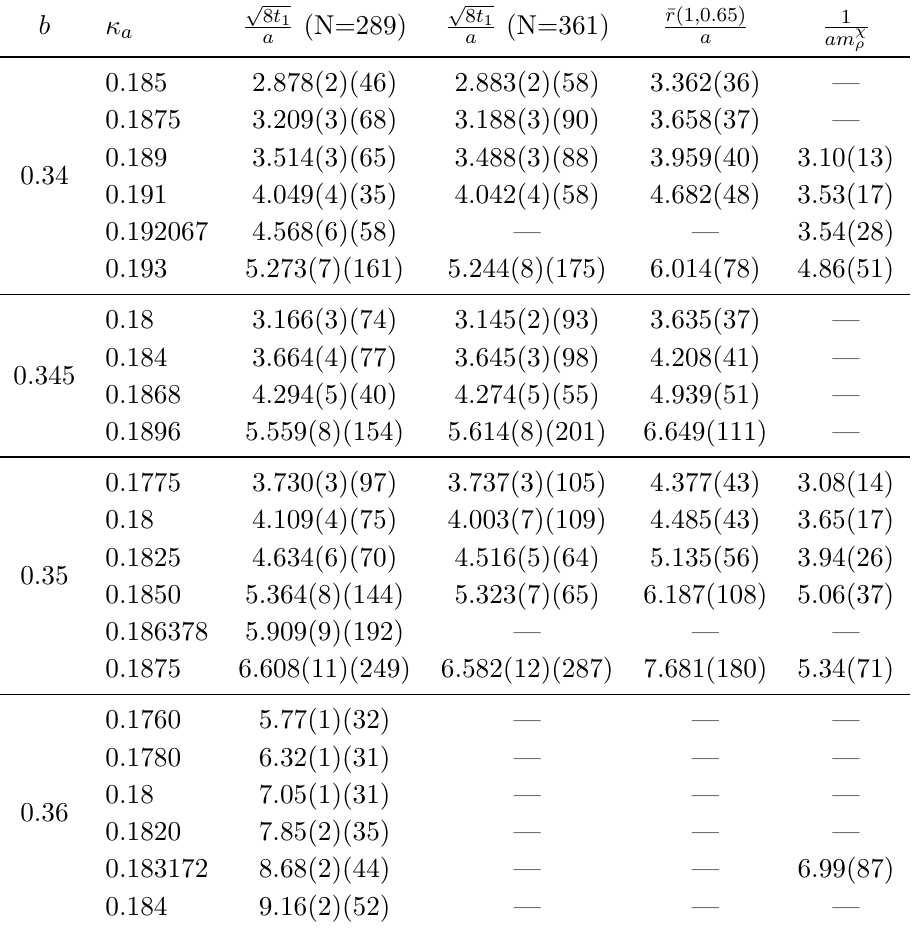
Table 5. Values of the inverse lattice spacing in units of the three different scales determined in this work. For flow related scales, the first error is statistical, the second is